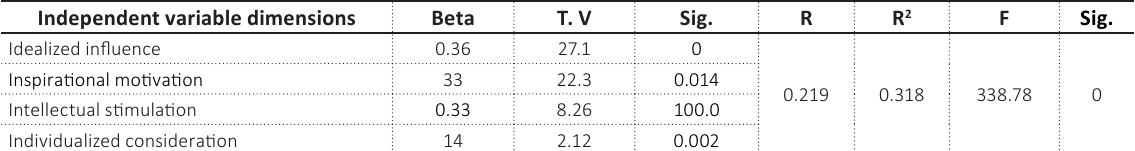
Table 4. Relationship between transformational leadership dimensions and fairness of pay and promotion